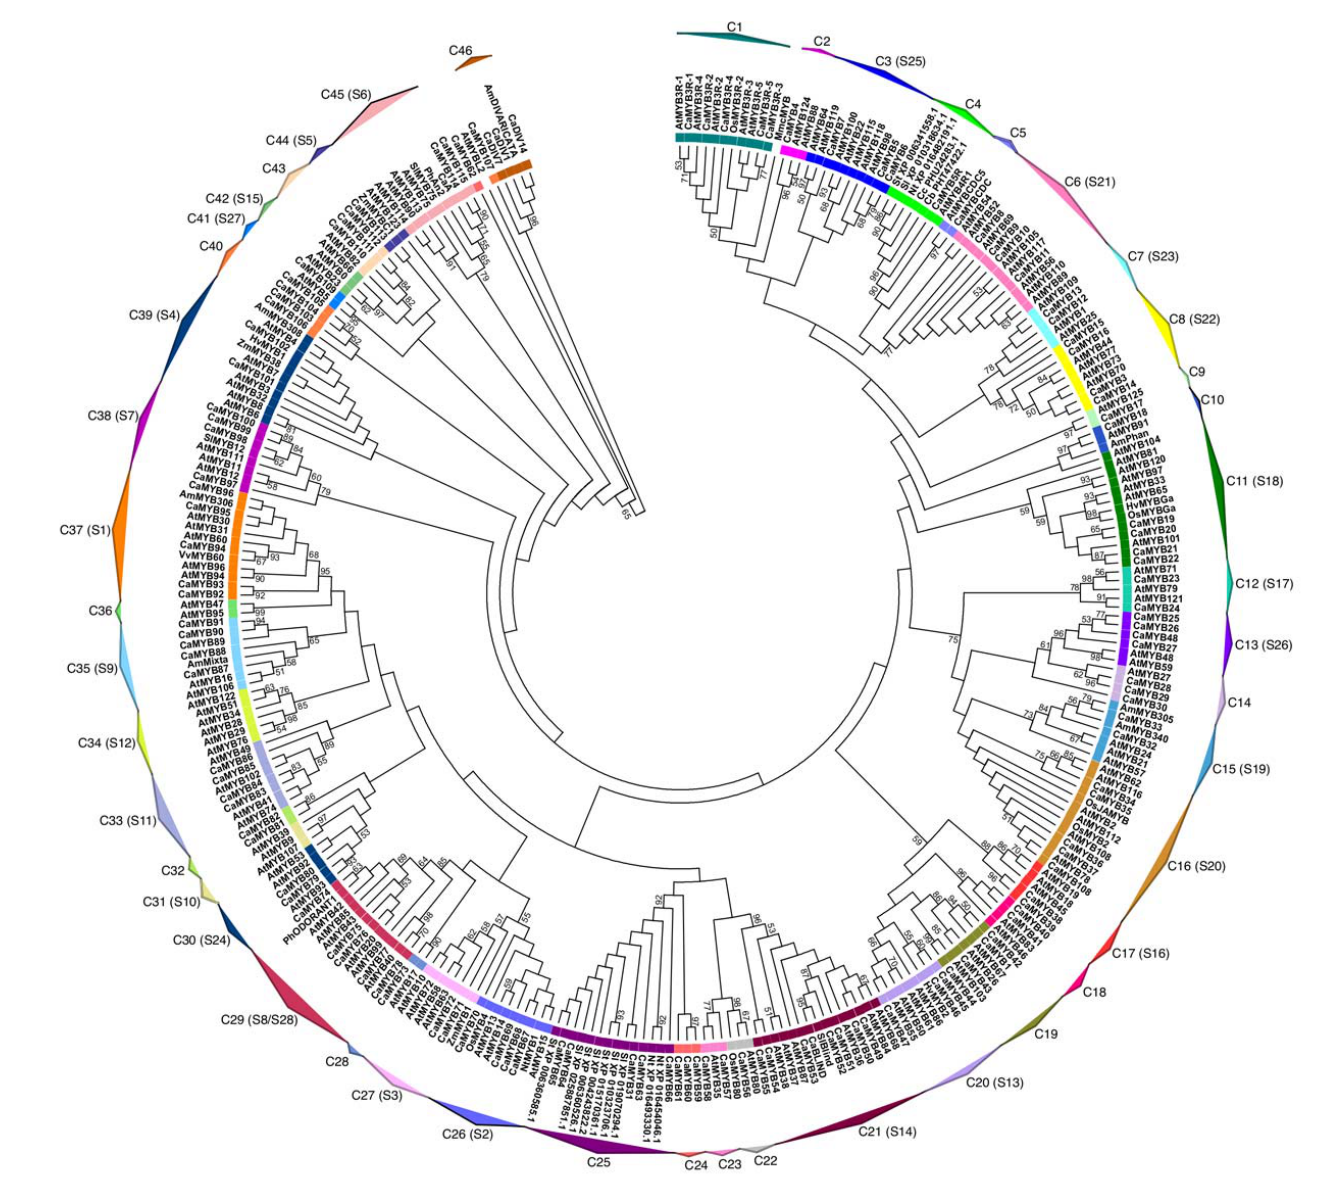
Figure 1. Phylogenetic relationship of CaMYB proteins with other plant MYB transcription factors. A phylogenetic tree was constructed using the Neighbor-joining method based on the MYB domain alignment using the MEGA7 software, with 1000 bootstrap replicates. The tree shows the 46 clades (C1–C46) with a high bootstrap value (highlighted with colored squares for each clade). Bootstrap values >50 are indicated on the nodes. Ca: Capsicum annuum ; Cb: Capsicum baccatum ; Cc: Capsicum chinense ; At: Arabidopsis thaliana ; Sl: Solanum lycopersicum ; St: Solanum tuberosum ; Nt: Nicotiana tabacum ; Am: Antirrhinum majus ; Os: Oryza sativa ; Mm: Mus musculus ; Hv: Hordeum vulgare ; Zm: Zea mays ; Ph: Petunia hybrida ; Vv: Vitis vinifera . Accession numbers for all protein sequences are listed in Tables S1 and